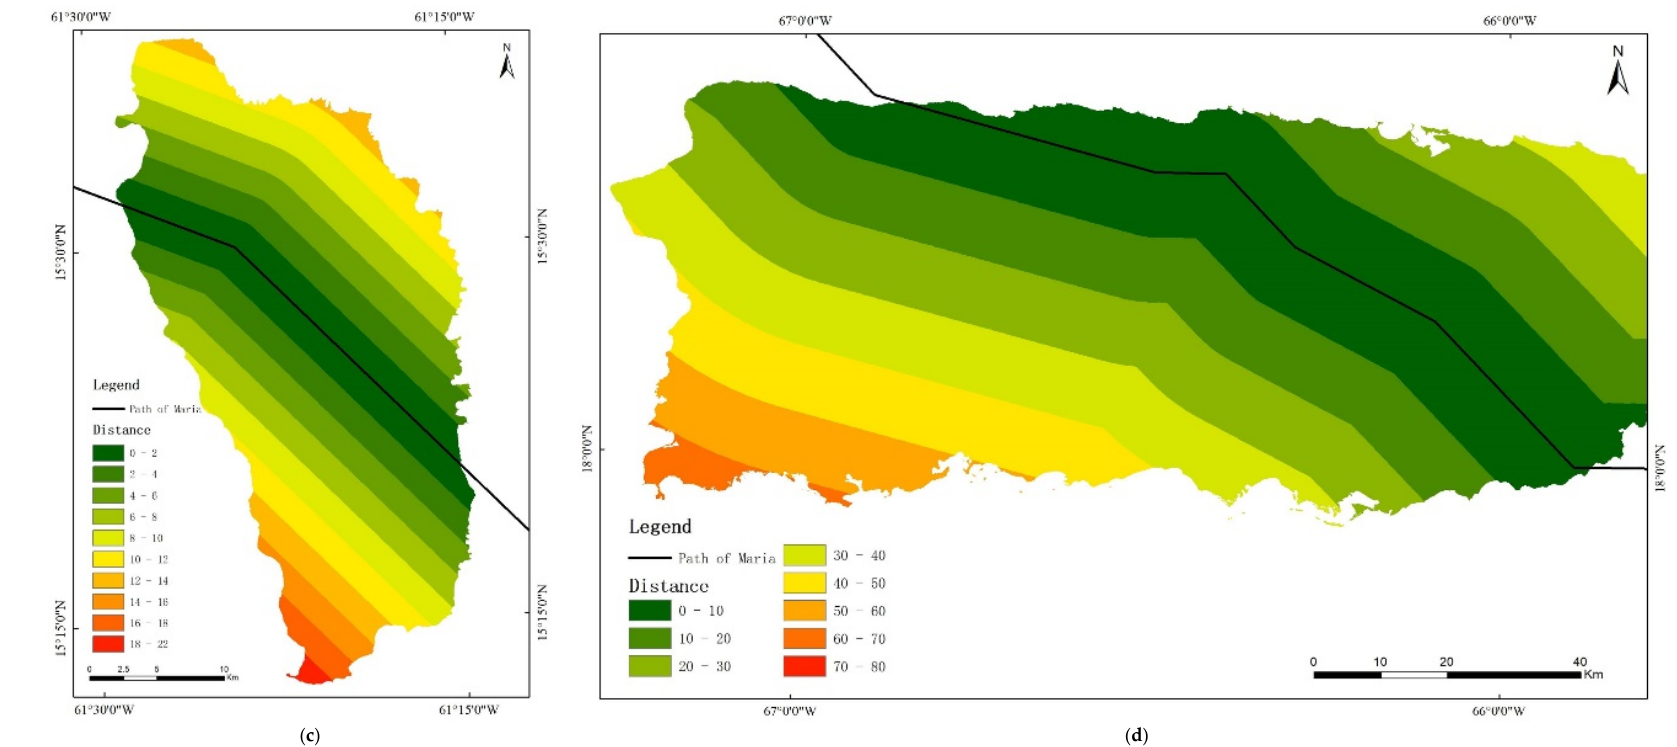
Figure 6. The elevation classification (meters) and distance maps (kilometers). ( a ) The elevation classification map of Dominica; ( b ) the elevation classification map of Puerto Rico; ( c ) the distance map of Dominica; ( d ) the distance map of Puerto Rico.